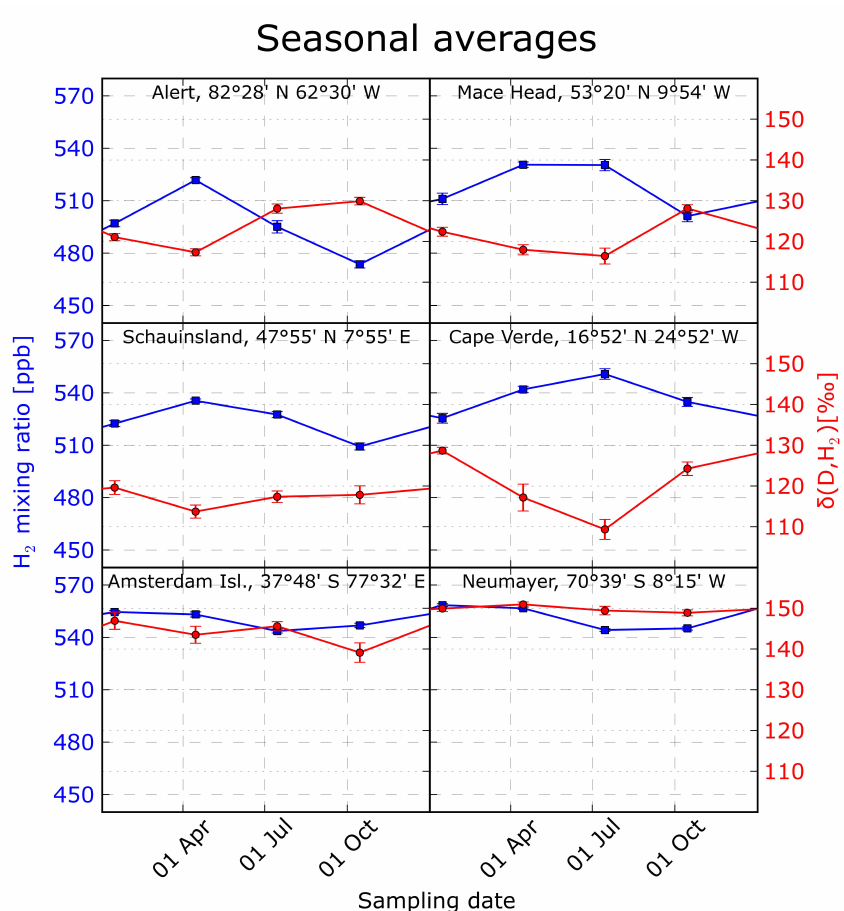
Fig. 3. Seasonal averages of m (H 2 ) (UHEI, LSCE and MPI-BGC) and δ D (IMAU) plotted versus time of year. Error bars indicate one standard error, which is calculated purely from variance in the values obtained for one